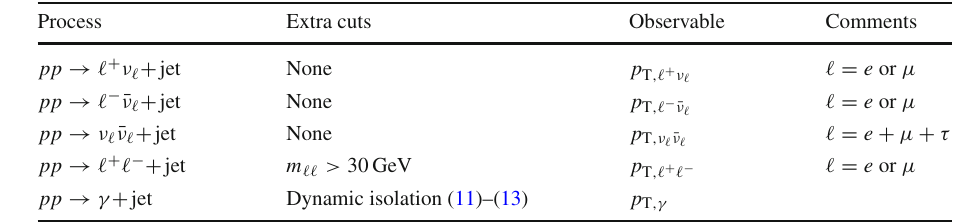
Table 1 Extra selection cuts, in addition to Eq. (15), and observables for the various V + jet processes. Alternative predictions for γ +